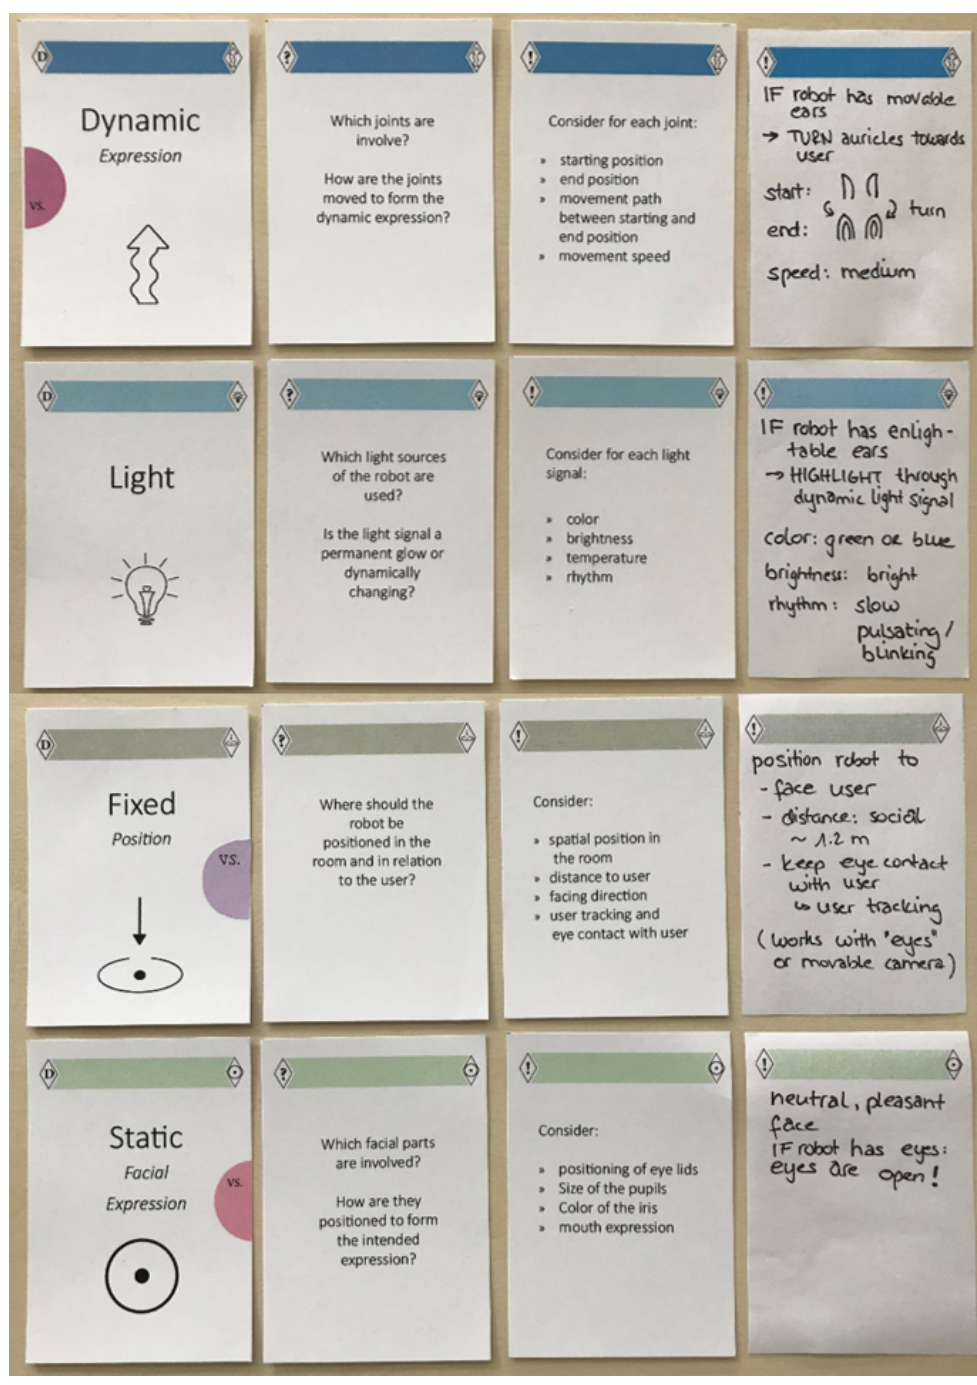
Figure 5. Decision, investigation, parameter and idea cards for the robot action “listen to